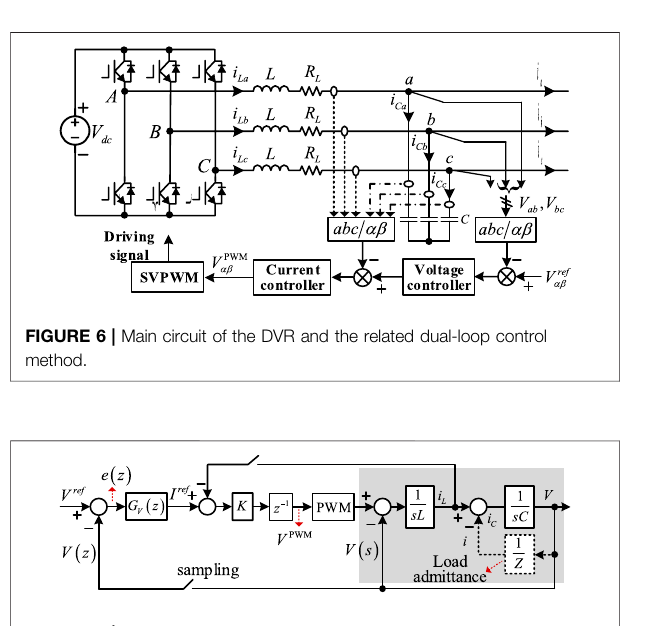
FIGURE 7 | Block diagram of the dual-loop control method.